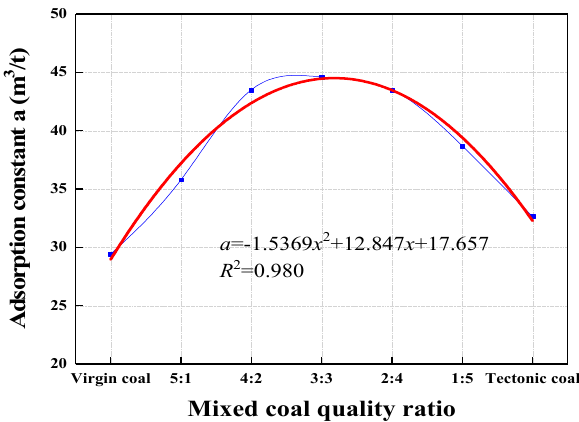
Figure 7. Relationship between the adsorption constant a and the mass ratio of hard to soft coal.